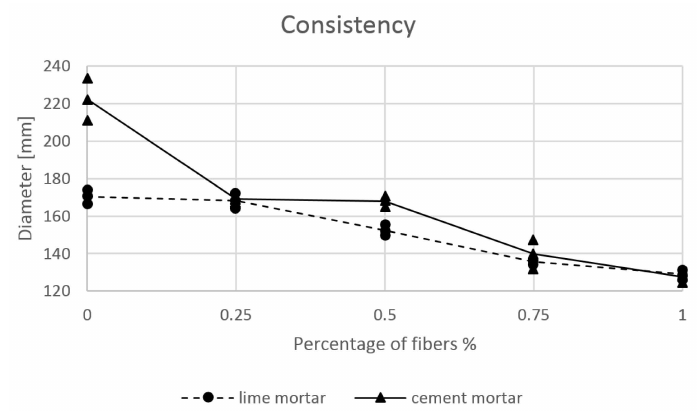
Figure 6. Consistency measurements.